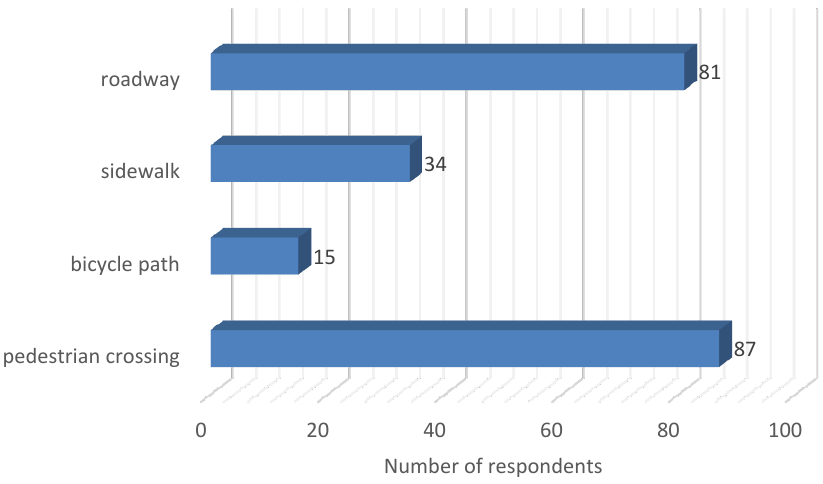
Figure 7. Place of the occurrence of road accidents according to the respondents.